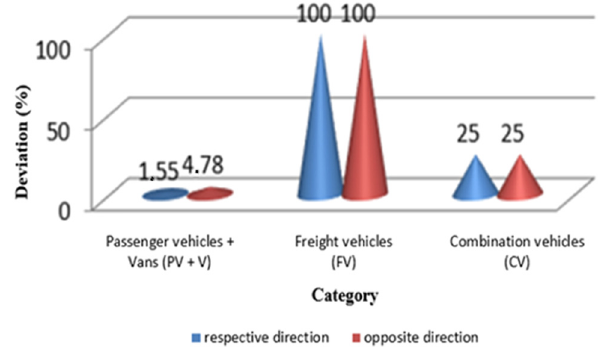
Figure 8: Speedometer deviation for the individual vehicle cate - gories ( 3rd survey ) .